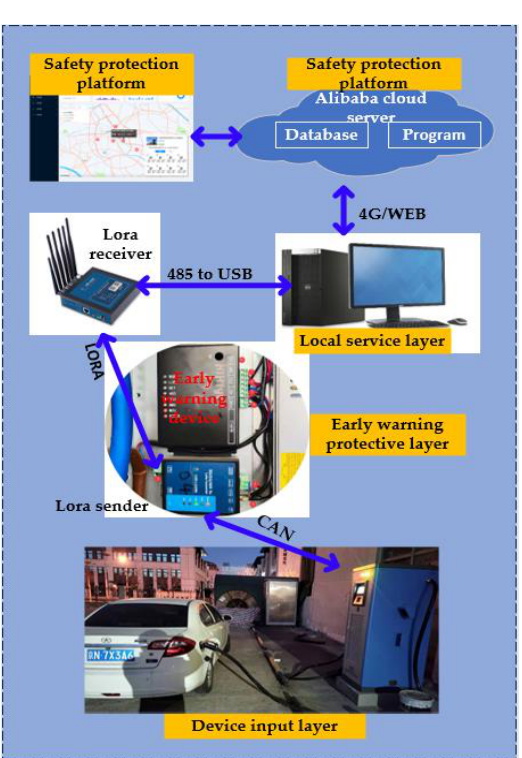
Figure 8. Physical platform of EV charging safety protection early warning system.